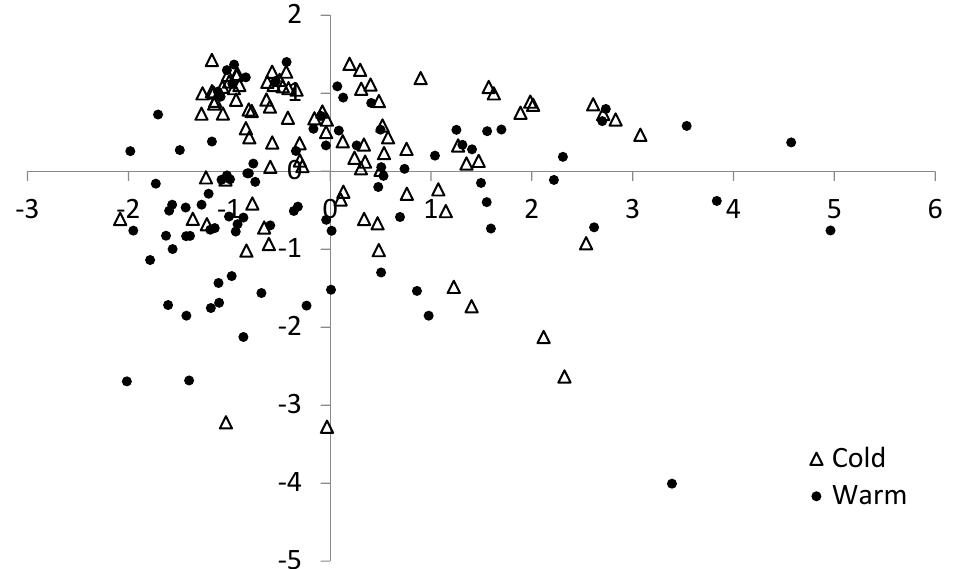
Figure 7. PCA Biplot showing negative relationships between cyanobacteria and water levels and discharge rates while other phytoplankton showed positive relationships to the two hydrological factors. Trends in phytoplankton biomass and related water chemistry were compared for periods of above-average and below-average water levels (Figure 8). The averaged biomass of cyanobacteria in years with above-average water levels were significantly lower than in years with below-average water levels. Other eukaryotic phytoplankton showed a contrasting trend, with higher averaged monthly biomass in years with higher water levels. In terms of other environmental parameters, average TN concentrations did not differ between periods of high and low water levels, but TP and color (CDOM) were significantly higher during years of high rainfall and elevated water levels.